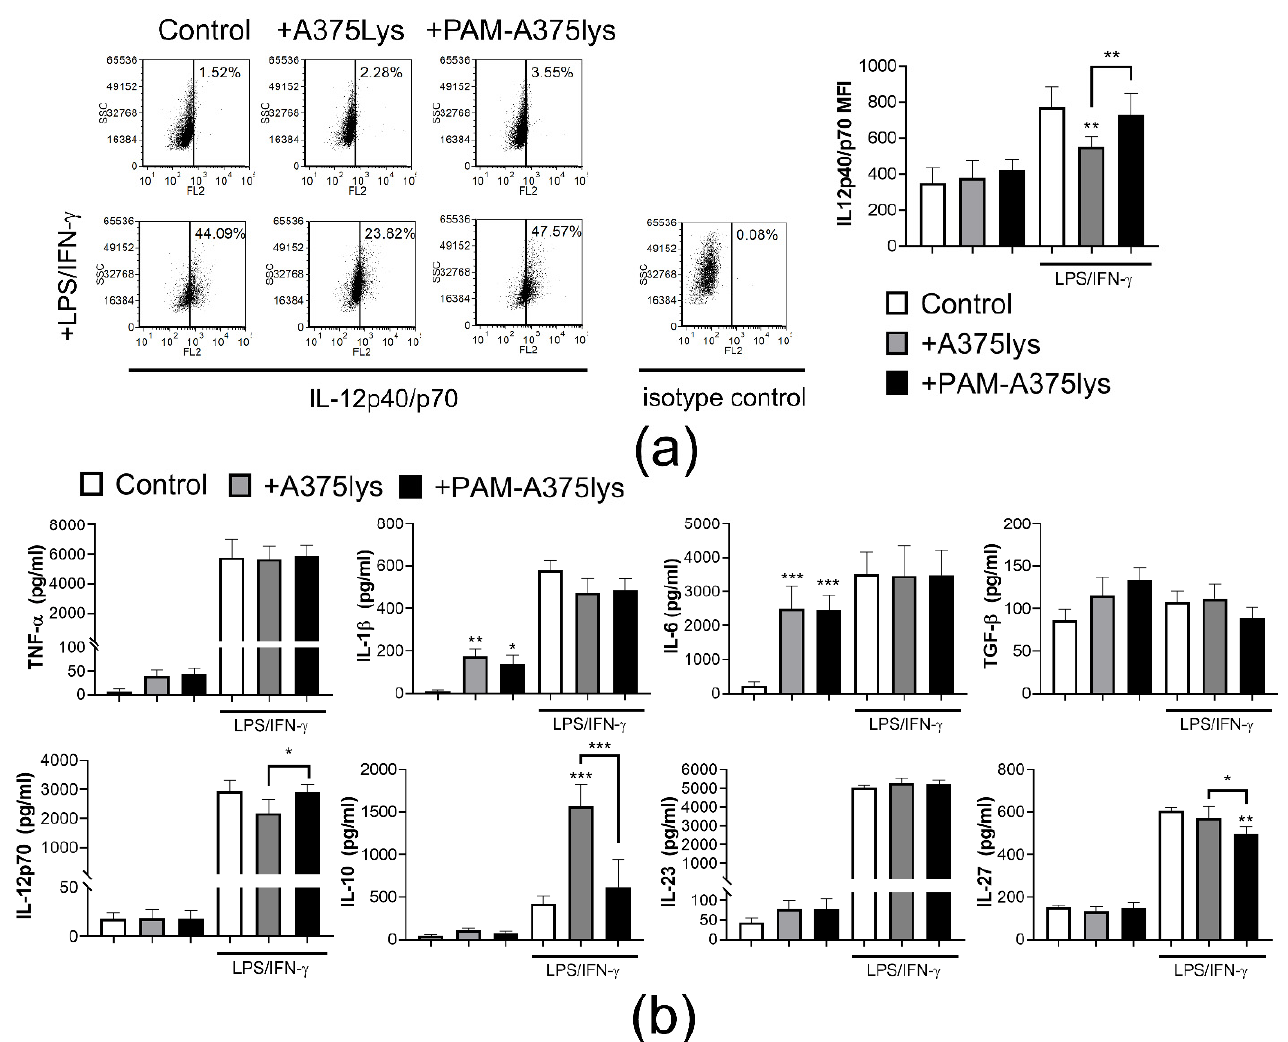
Figure 5. Effects of PAM-treated A375 lysates on cytokines expression by DCs. Immature DCs differentiated for 4 days in the presence of GM-CSF/IL-4, were treated with A375 lysate or PAM-treated A375 lysate at 1:1 A375: DC ratio, and after 4 h they were treated with LPS/IFN- γ or not, for the next 16 h. ( a ) A representative experiment on IL-12p40/p70 expression analysis is shown, and the summarized data from 3 independent experiments (with different DC donors) are shown as mean fluorescence intensity (MFI) ± SD. ( b ) The levels of indicated cytokines detected by ELISA in the cell-culture supernatants are shown as pg/mL ± SD. * p < 0.05, ** p < 0.01, *** p < 0.005 vs. corresponding control DCs (white bars) or as indicated with lines (RM-ANOVA, Tukey’s multiple comparison test). Statistical significance between the corresponding iDCs and mDCs was not indicated for clarity.